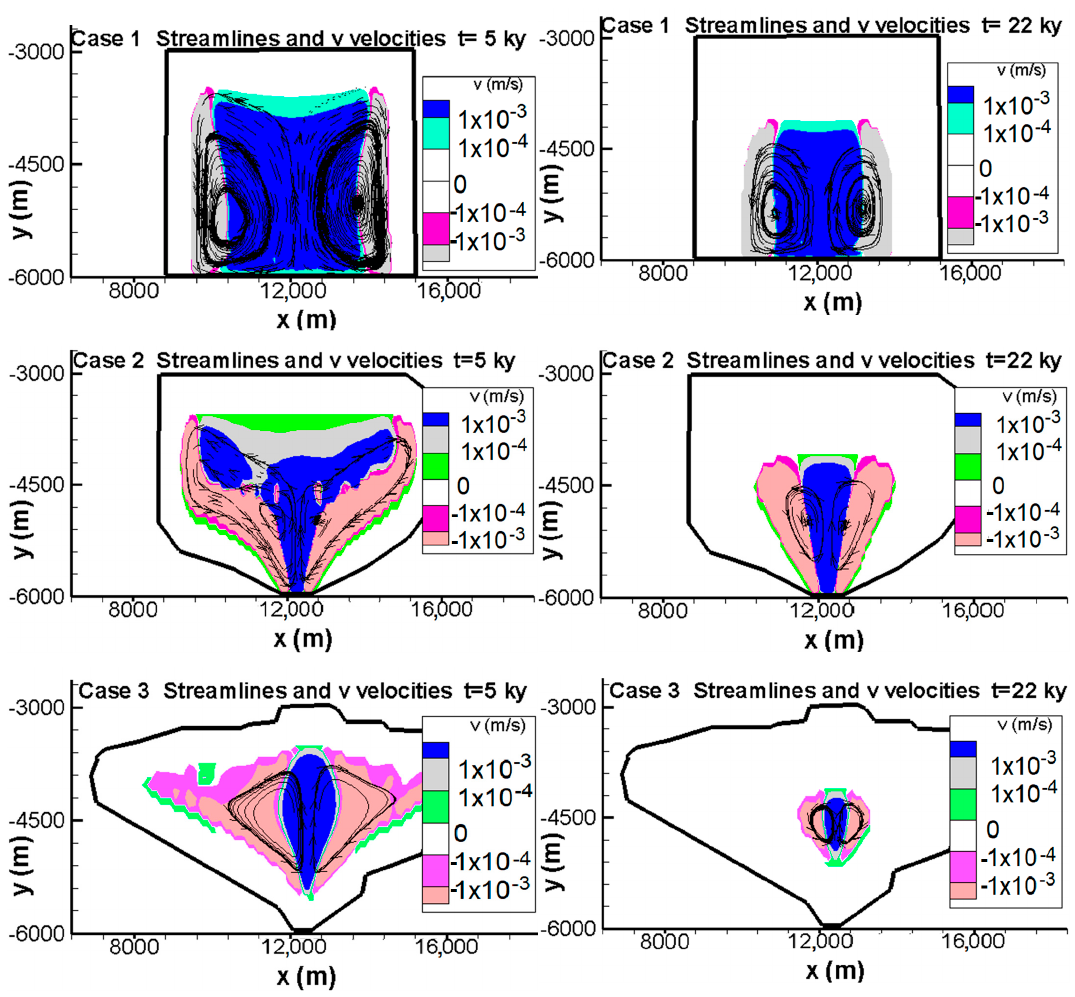
Figure 6. Streamlines and v velocity distributions at two different times inside the chamber. Natural convection produces movement of magma in zones having temperatures of 1498 K to 1223 K.